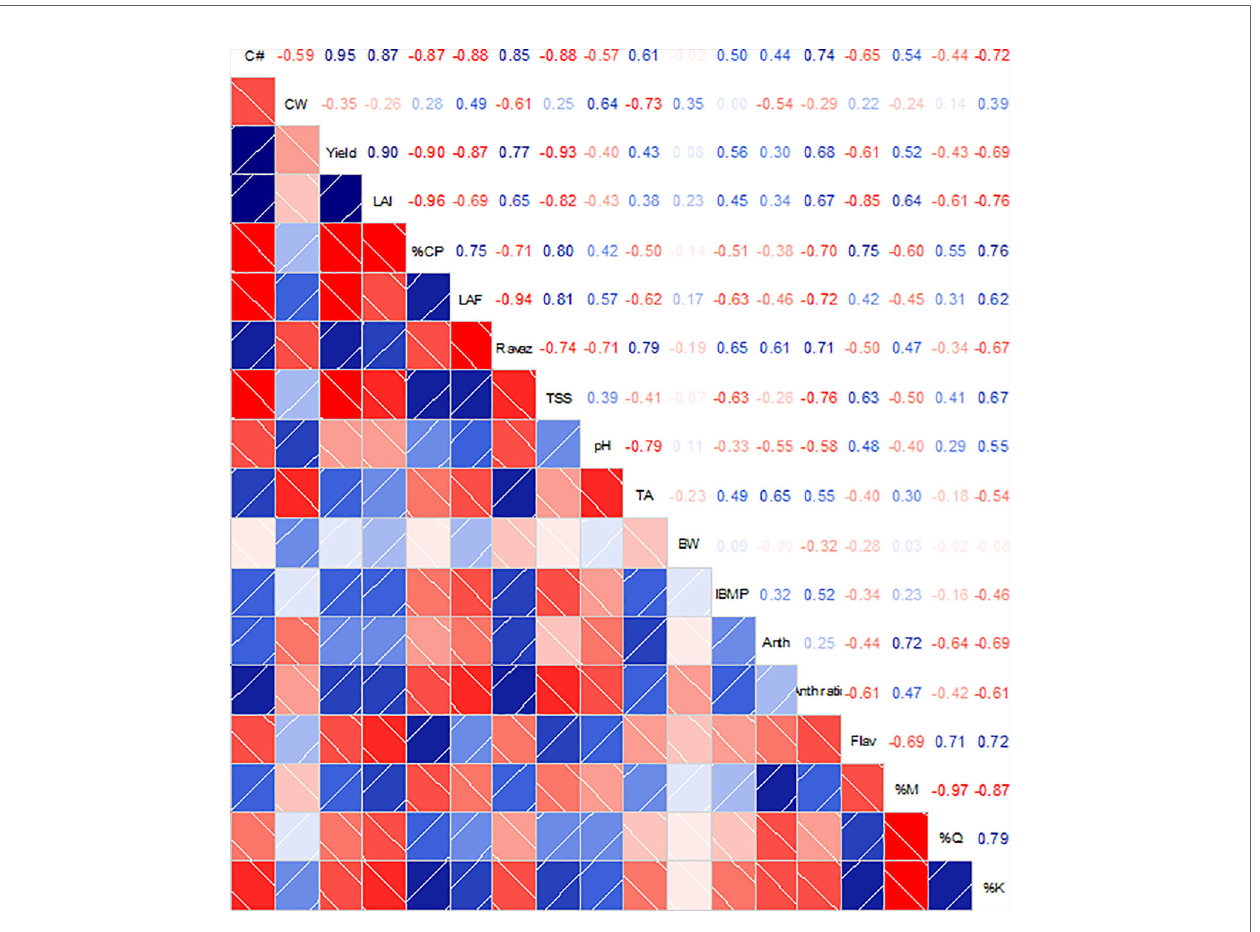
FIGURE 7 | Correlation matrices among grapevine canopy architecture, yield components, berry mass and must compositions and fl avonoid content and pro fi le from Cabernet Sauvignon grapevines subjected to different canopy management practices (UNT, untreated; LR, Leaf removal; ST, Shoot thinning; LRST, LR and ST combined) at harvest. Upper panel shows the R values for the Pearson's correlation analysis. Intensity of blue or red colors in the upper and lower panels represents the signi fi cance of the relationship between variables. White lines in lower panel represent the regression curves for each pair of variables. C#, cluster number; CW, cluster mass; LAI, Leaf Area Index; %CP, % canopy porosity; LAF, leaf area to fruit ratio; RI, Ravaz Index; TSS, total soluble solids; TA, titratable acidity; BW, berry mass; Anth, total anthocyanins; Flav, total fl avonols; %M, % myricetin; %Q, % quercetin; %K, % kaempferol; %Dp, % delphinidin; %Cy, % Cyanidin; %Pt, % Petunidin; %Pn, % Peonidin; %Mv, %